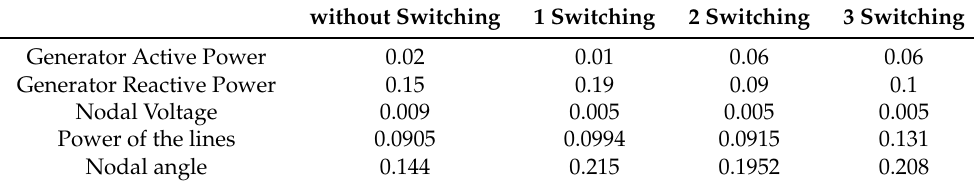
Table 5. Comparative analysis between average error in [p.u] of Algorithm vs.